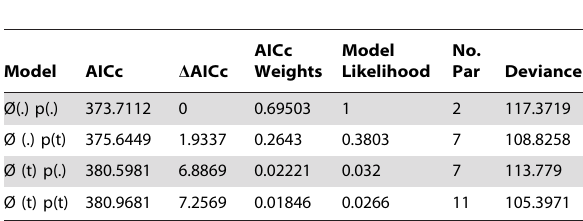
Table 2. Survival models fitted for Megaptera